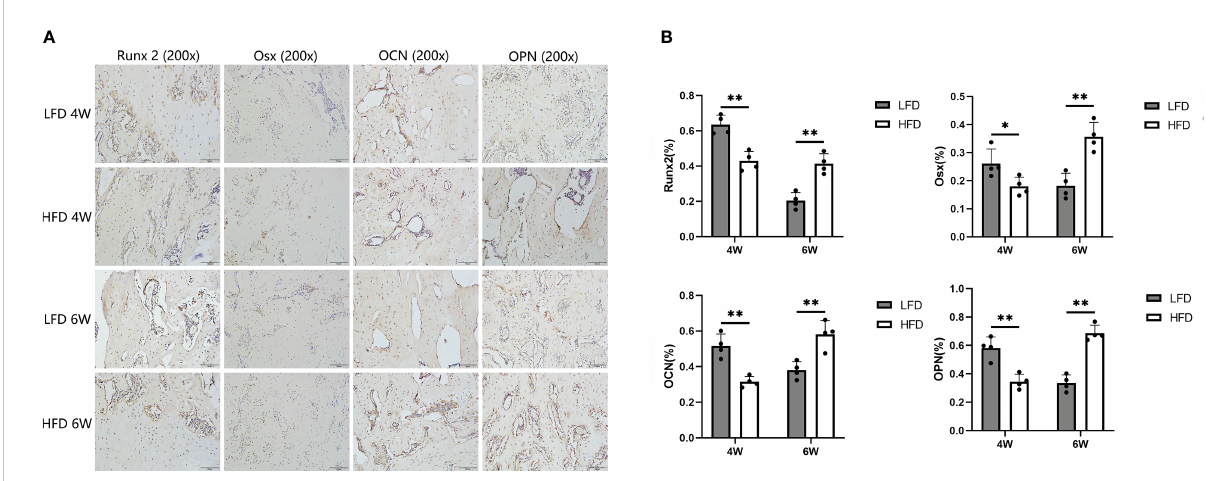
FIGURE 8 Immunohistochemical analysis. (A) Immunohistochemistry images of Runx 2, Osterix, OCN, and OPN in the two groups at the termination of 4- week and 6-week consolidation. (B) The semiquantitative measurements showed the 4 markers were highly expressed in LFD group compared to HFD group after 4 weeks of consolidation. At the termination of the 6-week consolidation, these indicators were lower expressed in LFD group compared to HFD group. (*P<0.05,